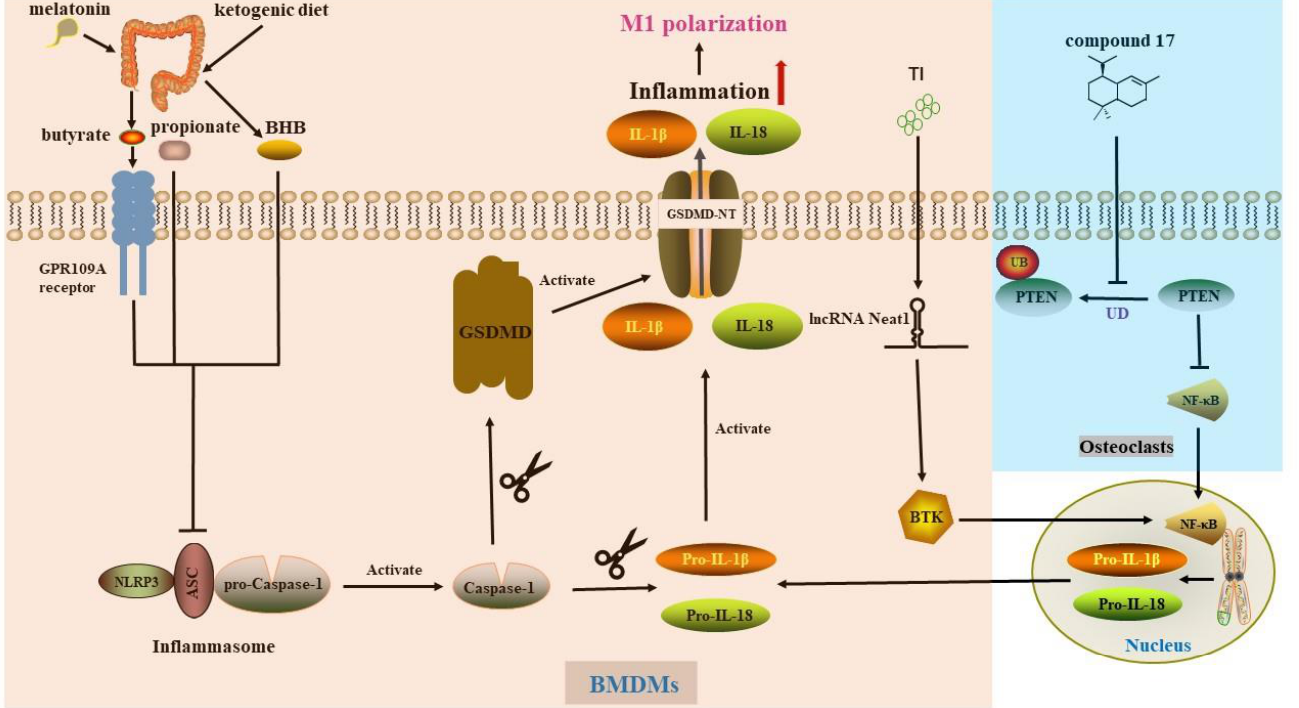
Figure 1. Pyroptosis in macrophages or osteoclasts. The NLRP3 inflammasome activates caspase-1, which activates GSDMD, the precursor of Pro-IL- 1β and Pro -IL-18, respectively. Subsequent oli- gomerization of GSDMD-NT forms transmembrane pores in the plasma membrane, resulting in the release of IL- 1β and IL -18. Melatonin increases butyrate content by affecting gut microbiota, which inhibits NLRP3 activation by binding to the GPR109A receptor. Both propionate and butyr- ate attenuate NLRP3 activation by inhibiting ASC assembly, but propionate is GPCRs-independ- ent and HDAC-independent. BHB alleviates NLRP3 activation by inhibiting HDAC. TI particle